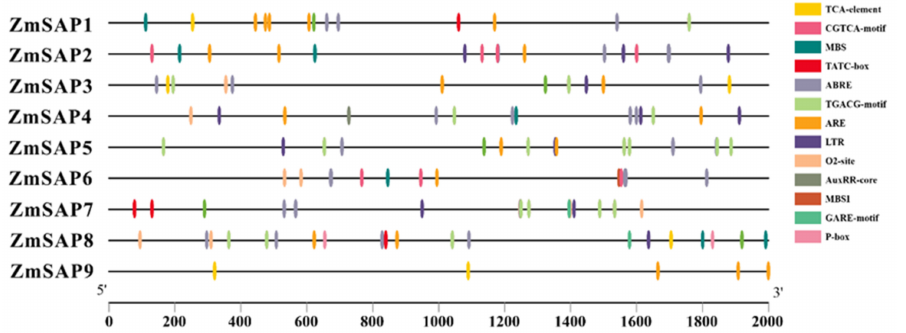
Figure 7. Prediction of cis-elements in the promoter regions of ZmSAPs